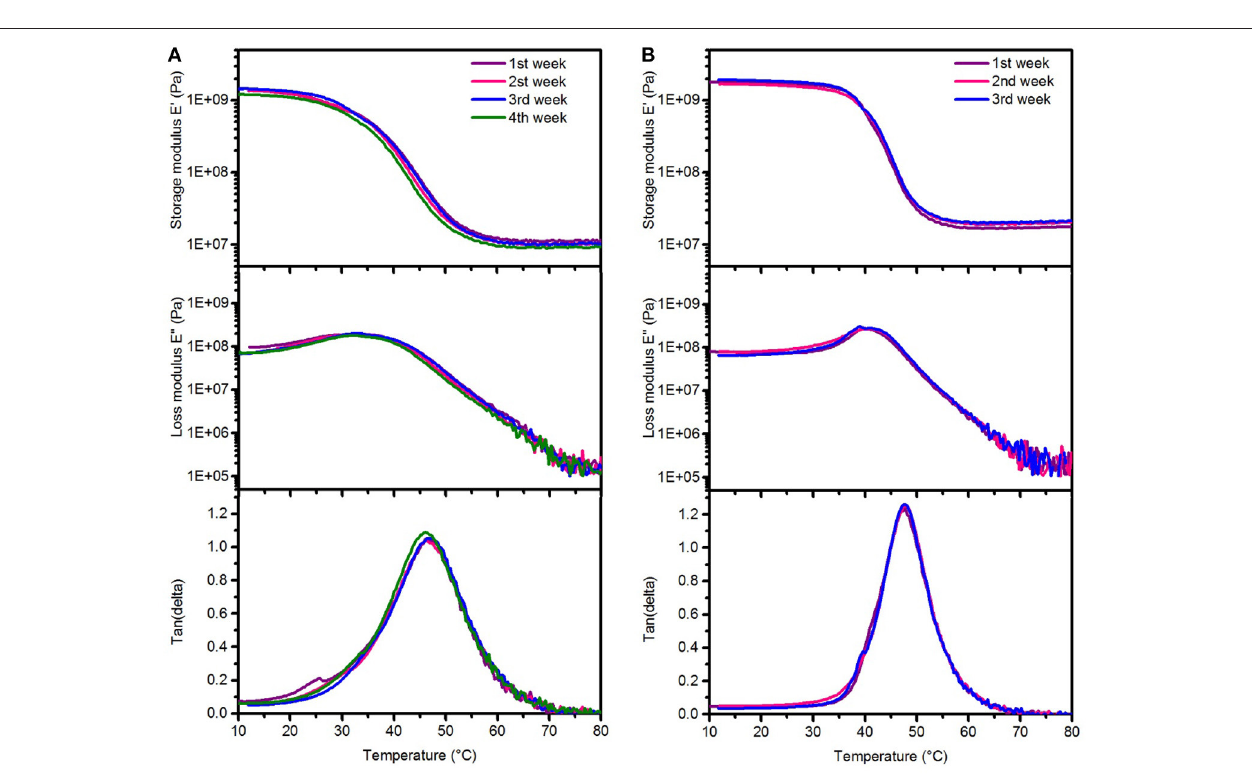
FIGURE 6 | Representative dynamic mechanical analysis after aging test in 1M NaOH solution showing changes in the storage modulus (top), loss modulus (center), and tan delta (bottom) after various aging times at 37 ◦ C (A) SMP-A (B) SMP-B.